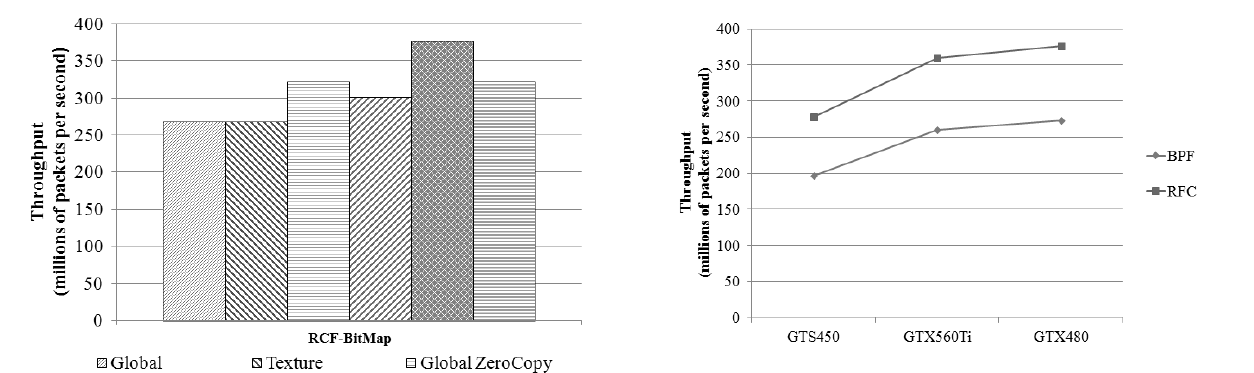
Fig. 14. Throughput comparison between two GPU-based fiilter algorithms on different CUDA devices.